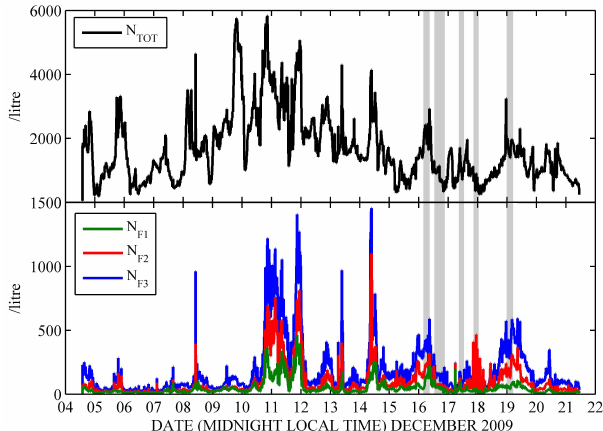
Fig. 1. Time series of WIBS3 number concentrations in Manch- ester 2009. Filter samples were collected in the periods marked by shaded areas.